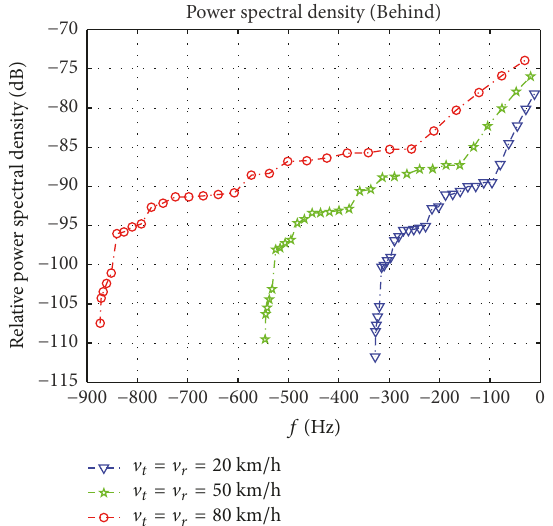
Figure 6: Behavior of PSD 𝑆(𝑓) presented in (10) and Figure 3(b) for V2V scenarios with different moving speeds of Tx/Rx vehicles.